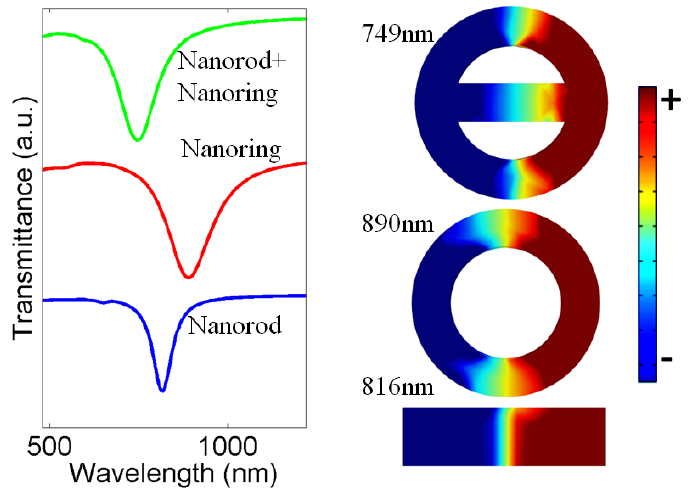
Figure 2. Transmittance spectra of nanorod (blue curve), nanoring (red curve), compact ring/rod (green curve) structures. Inset shows surface charge distributions of all the structures at their resonant wavelengths. Where red indicates positive and blue indicates negative. Nanomaterials 2017 , 7 ,397